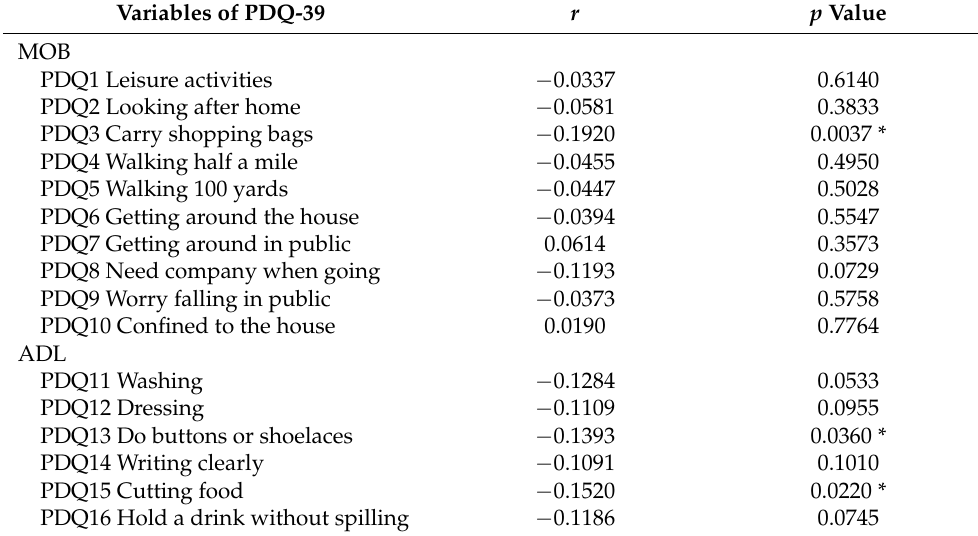
Table 5. Correlation between PDQ-39 MOB and ADL dimension with UPSIT, n =